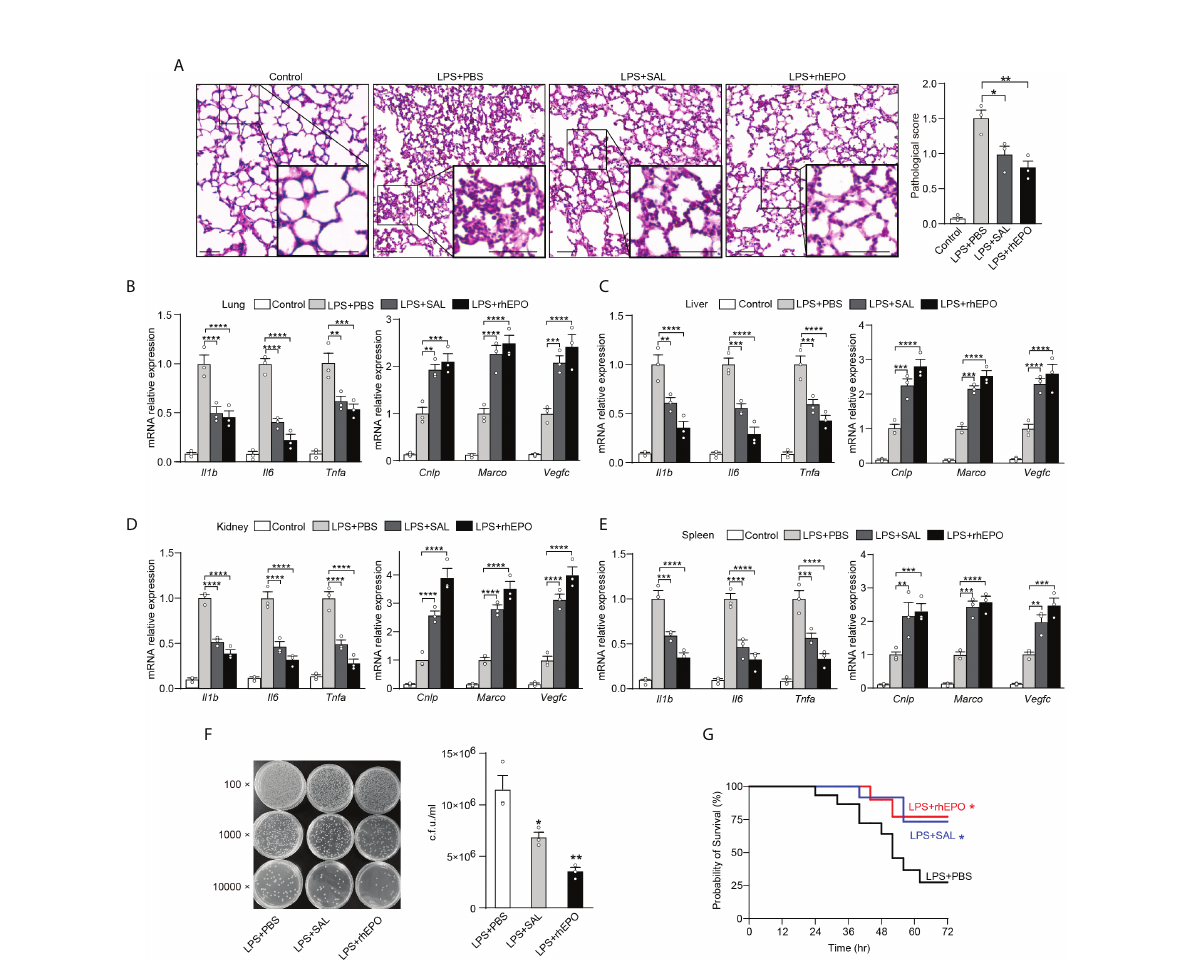
FIGURE 5 EPO and SAL protected LPS-tolerized mice from secondary infection of E . coli sepsis. WT C57BL/6 mice were intraperitoneally injected with LPS (1 mg/kg) + PBS, LPS (1 mg/kg) + rhEPO (5,000 IU/kg), or LPS (1 mg/kg) + SAL (40 mg/kg) for 24 h, and then mice were rechallenged with E. coli (10 7 CFU, i.p.) for 6 h. Control mice were injected with PBS only. (A) : Lung specimens stained with H&E for histological evaluation (bar = 100 m m, n = 3). (B – E) : qRT-PCR evaluation of gene expression in mice ’ s lung (B) , liver (C) , kidney (D) , and spleen (E) (n = 3). (F) : Bacterial titers in peritoneal lavage fl uids (n = 3). WT C57BL/6 mice were intraperitoneally injected with LPS (1 mg/kg) + PBS, LPS (1 mg/kg) + rhEPO (5,000 IU/ kg), or LPS (1 mg/kg) + SAL (40 mg/kg) for 24 h, and then mice were rechallenged with E. coli (10 7 CFU, i.p.) for 72 h for survival observation. (G) : Survival of mice (n = 15, log-rank test). Data are representative of three independent experiments. Results were expressed as means ± SEM. *P < 0.05, **P < 0.01, ***P < 0.001, and ****P < 0.0001. Statistics: one-way ANOVA (A, F) or two-way ANOVA (B – E) with Tukey ’ s post- hoc test for multiple